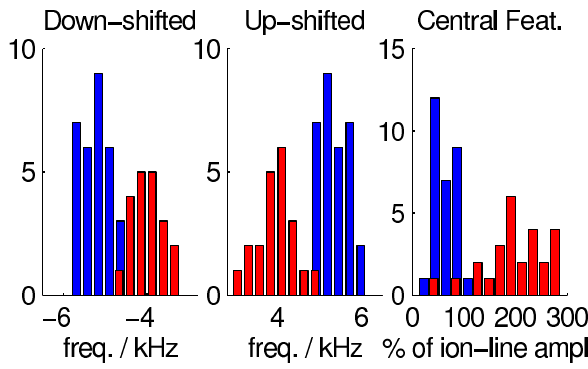
Fig. 3. Same as Fig. 2 for heating cycle O2 (17:00–17:02UT).